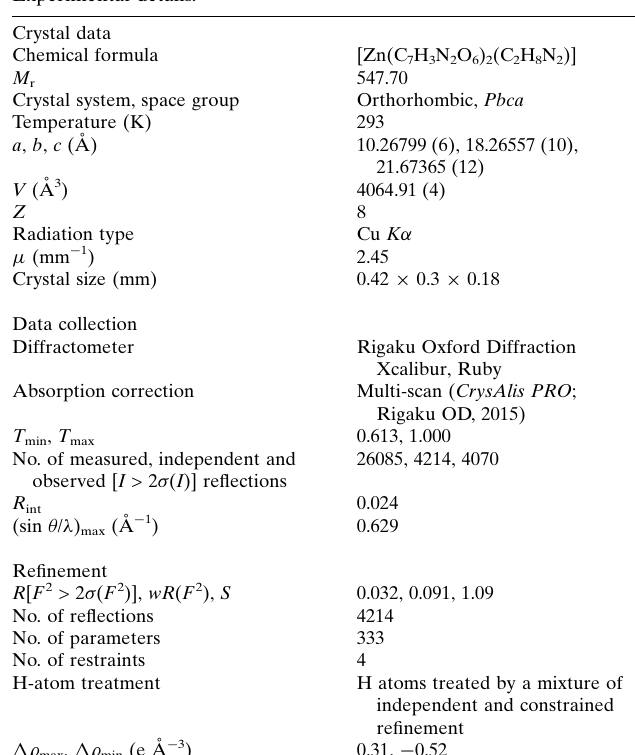
Table 3 Experimental